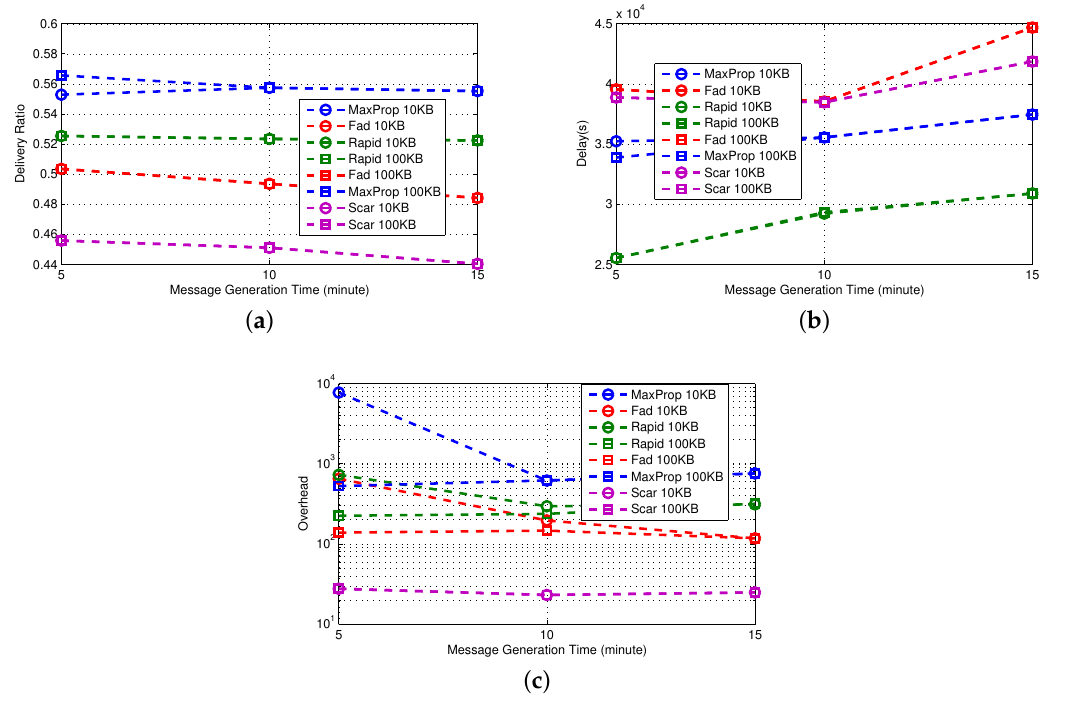
Figure 10. Performance of advanced protocols in a real-world outdoor